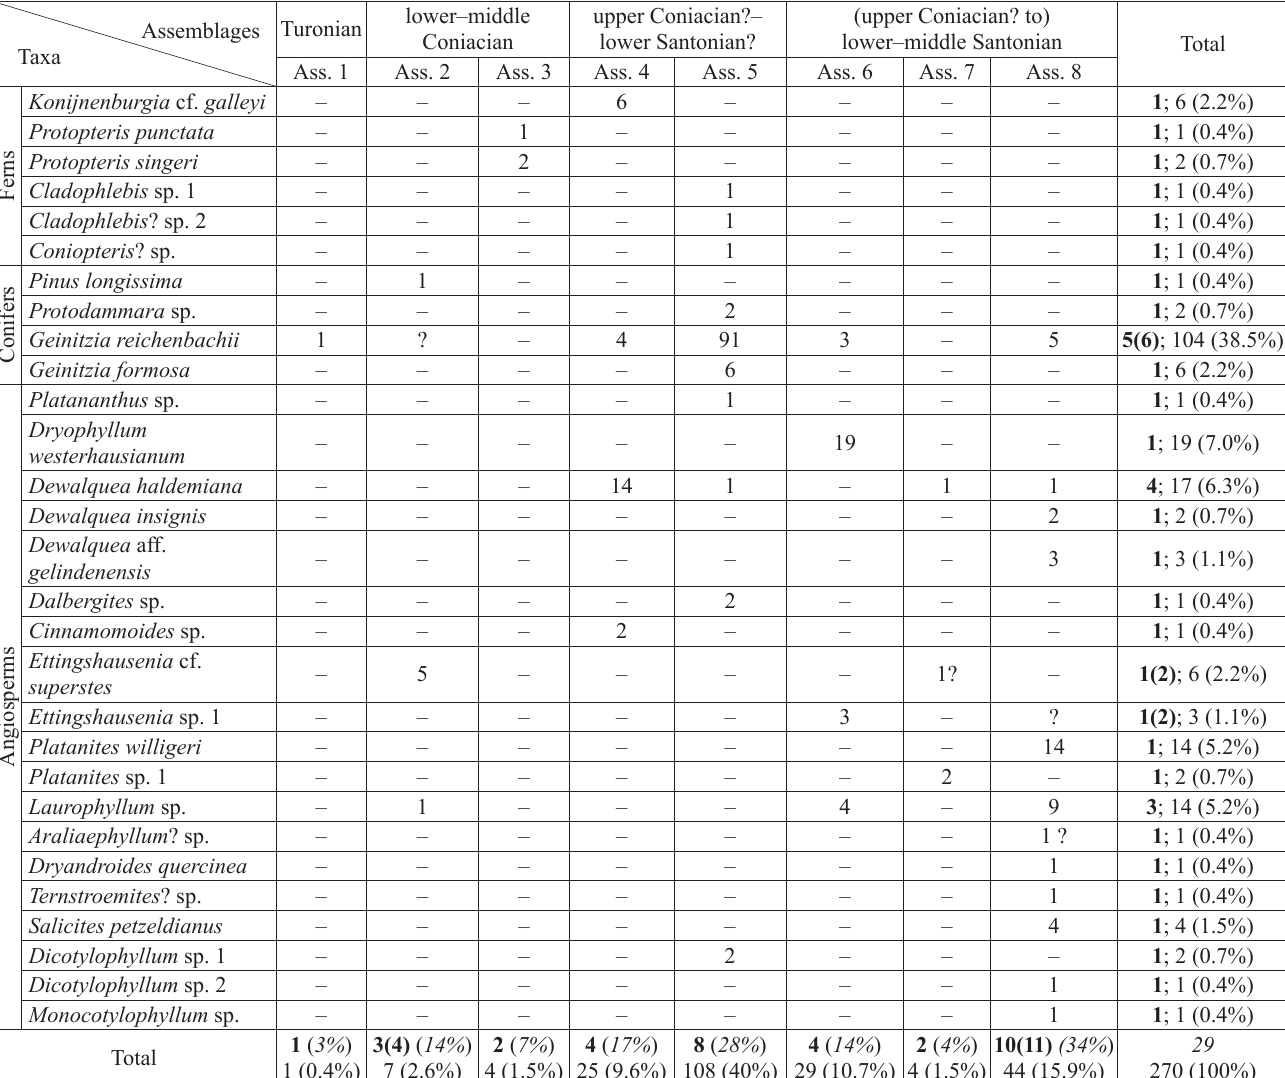
Table 2. Summary of distribution of the studied plant species within the assemblages. Numbers in single cells are numbers of specimens. These are added within rows, representing the total number of specimens of a species and percentages referring to the total number of specimens (270), and within columns, representing the total number of specimens within an assemblage (percentages as above). The totals in bold in the last column indicate in how many assemblages a species is present; those in bold in the last row indicate of how many species an assemblage is composed; the percentages in italics refer to the total number of species ( 29